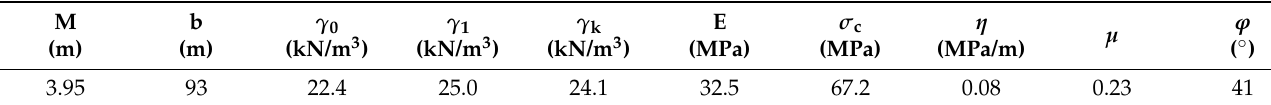
Table 2. Parameter values of panel 2129 (data from Figure 2a and an in situ experiment).